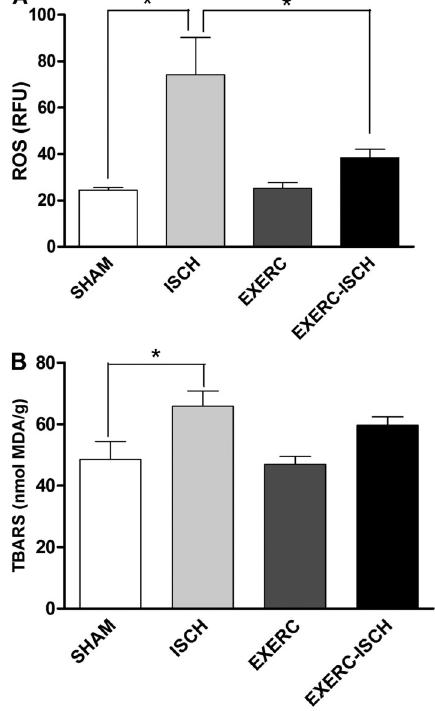
Figure 4. Transient global ischemia-reperfusion promotes an increase of reactive oxygen species and oxidative damage